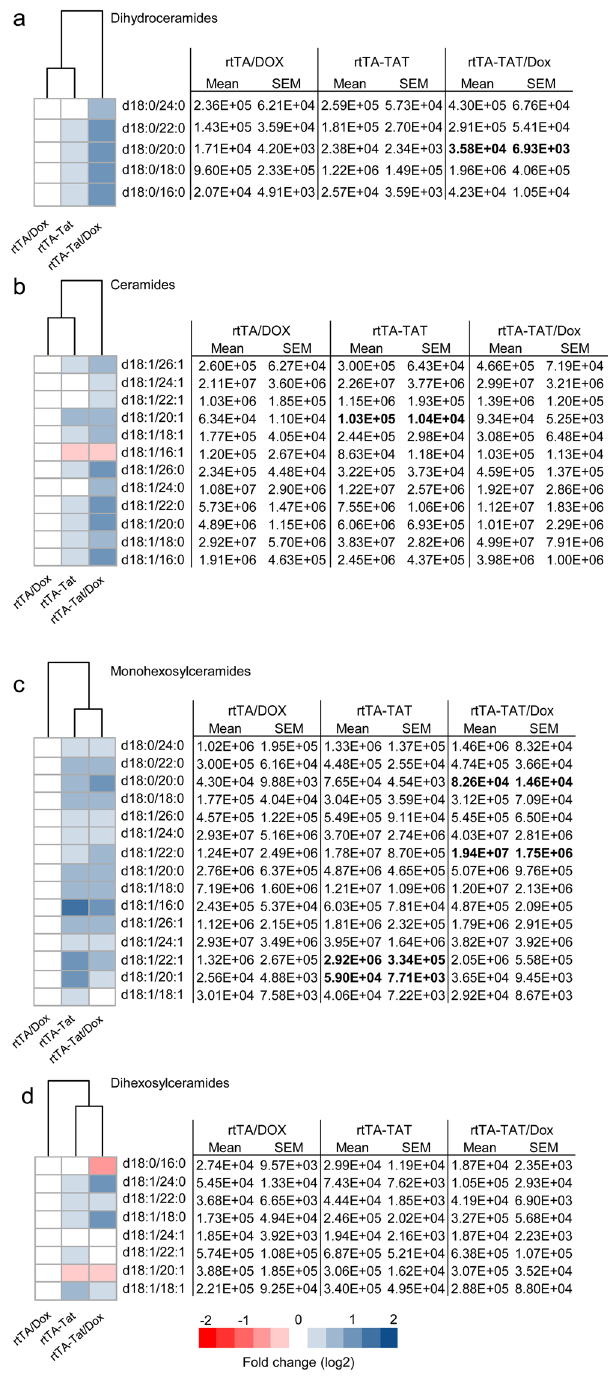
Figure 3. Accumulation of ceramide in cortex of rtTA-Tat mice. Concentrations of ( a ) dihydroceramides, ( b ) ceramides, ( c ) monohexosylceramides, and ( d ) dihexosylceramides, were determined in cortex of mice with the indicated genotypes. Hierarchal clustering analysis is shown to the left of each class of lipid. Blue colors indicates increase and red colors indicates decrease compared to rtTA control mice. Data are expressed as mean ± SEM, n = 6–7 per group. Bold text in table indicates p < 0.05 compared to rtTA control group. ANOVA with Tukey post hoc